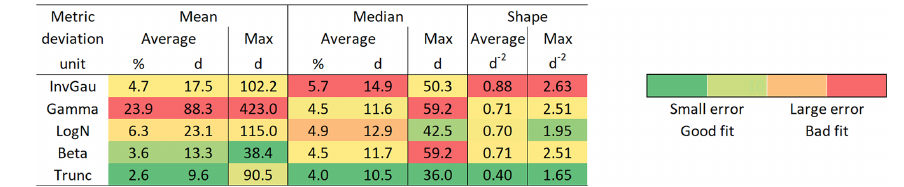
Table 3. Average and maximum deviations of mean and median transit times between the best-fit theoretical probability distributions and the modeled TTDs (given as the ratio of average deviation of the fitted distributions to the average modeled mean and median transit times as well as the average deviation in days). The sum of the squared residuals indicates the goodness of fit between the shape of theoretical probability distributions and modeled